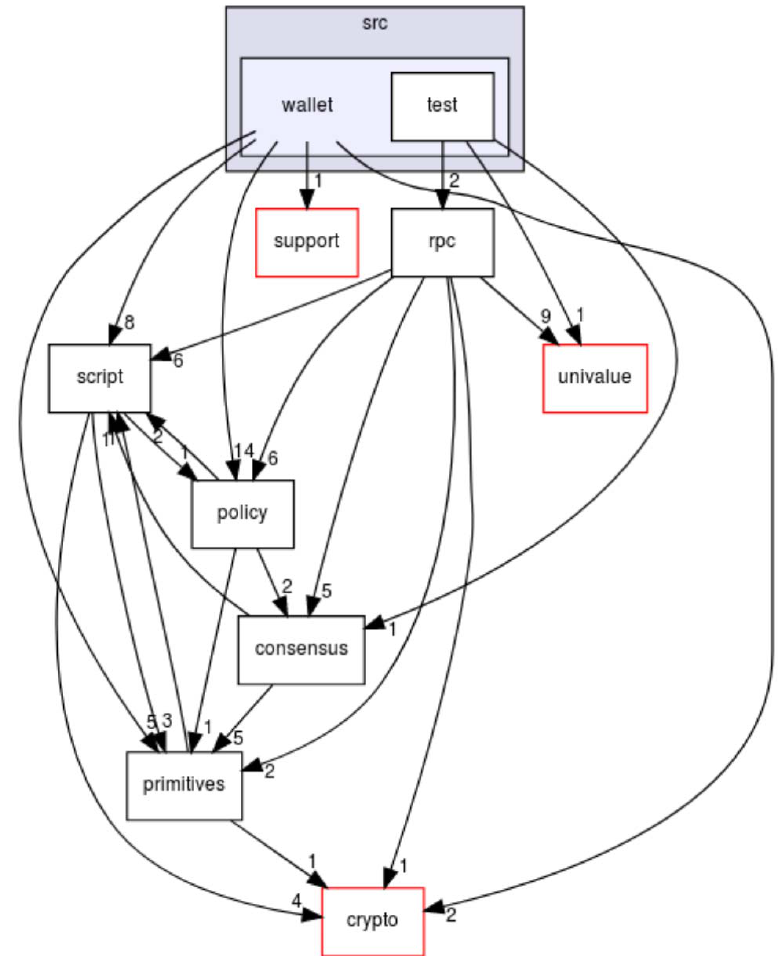
Figure 19. Smart grid of static Rainbowchain.